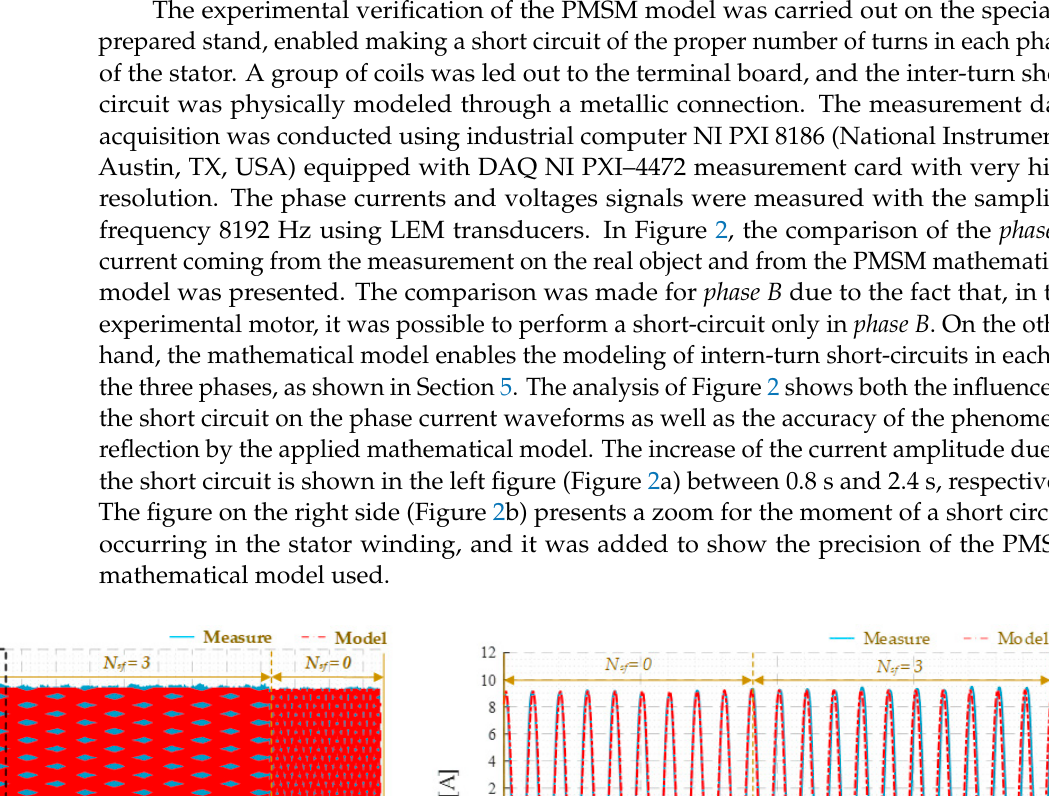
( b ) Figure 3. The spectral analysis of the PMSM stator current in phase B : ( a ) simulation results; ( b ) experimental results; T L = T N , f s = 100 Hz. 3. Open and Closed-Loop Speed Control of PMSM—Structures and Modeling The impact of a short circuit in the stator winding on the operation of the drive sys- tem was investigated in two PMSM motor control structures, modified scalar control and rotor flux-oriented control (FOC), described in the following subsections. 3.1. Open-Loop Scalar Control of PMSM